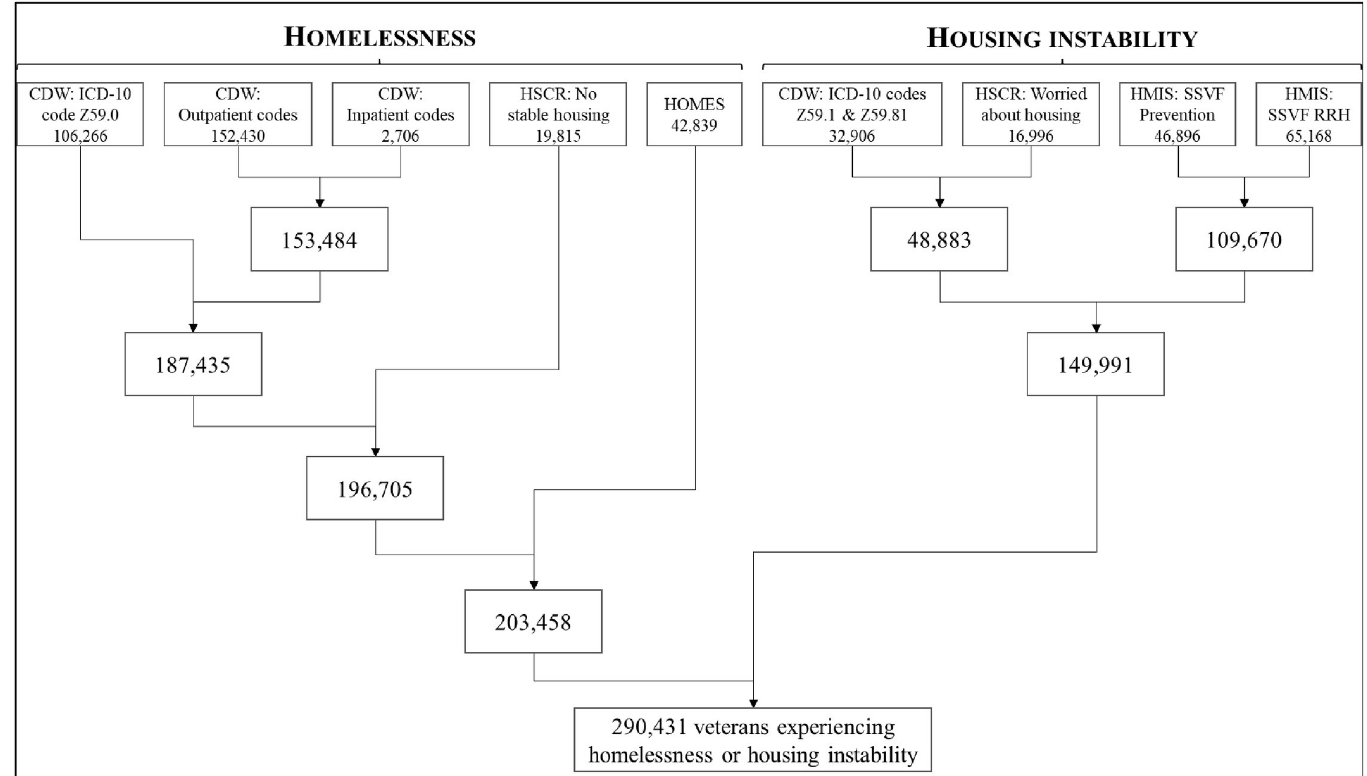
Fig 1. Numbers of homeless and unstably housed veterans identified with different data sources. Note: CDW = Corporate Data Warehouse; ICD-10 = International Classification of Diseases, Version 10; HSCR = Homeless Screening Clinical Reminder; HOMES = Homeless; HMIS = Homeless Management Information System; SSVF = Supportive Services for Veterans Families, RRH = Rapid